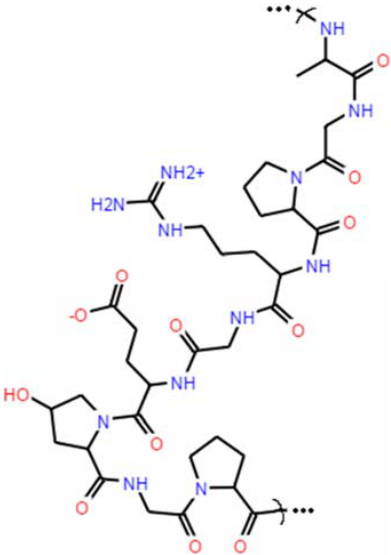
Figure 1. Representative gelatin structure according to its typical amino acid composition (adapted from N. Hanani et al. [11]).